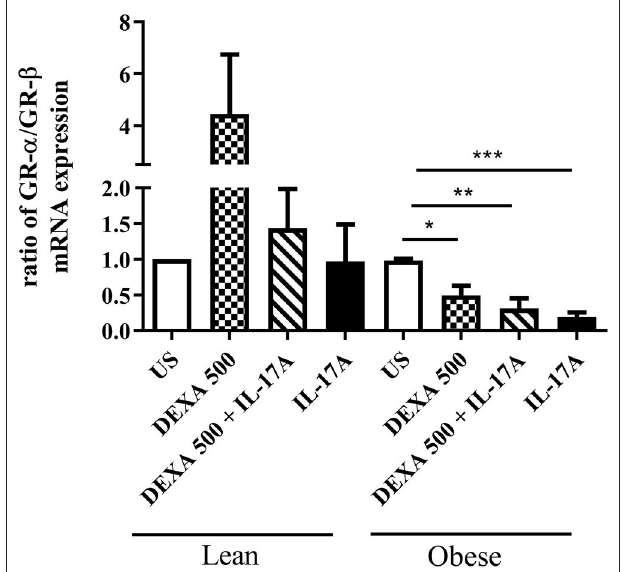
FIGURE 3 | Pre-treatment with Dexamethasone followed by IL-17A stimulation induces changes in GR- α /GR- β mRNA ratio. Adipocytes from lean and obese subjects were pre-treated with 500ng/ml dexamethasone followed by a 48h stimulation with 100ng/ml of IL-17A. mRNA expression of GR- α and GR- β were measured by qRT-PCR in duplicates using TaqMan probes. One independent experiment preformed per subject: n = 4 lean subjects, n = 3 obese subjects, One-Way ANOVA, Mean ± SE; * P < 0.05, ** P < 0.01, *** P < 0.001.